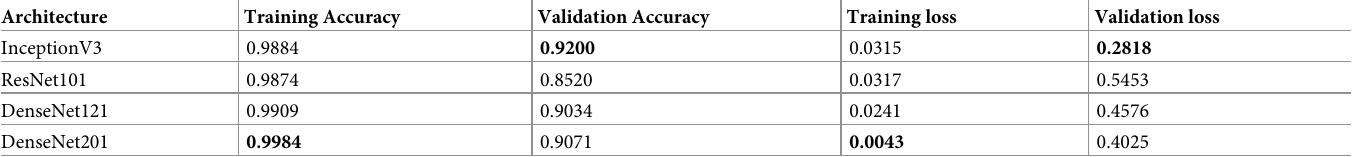
Table 2. Best performing configuration results for four different network